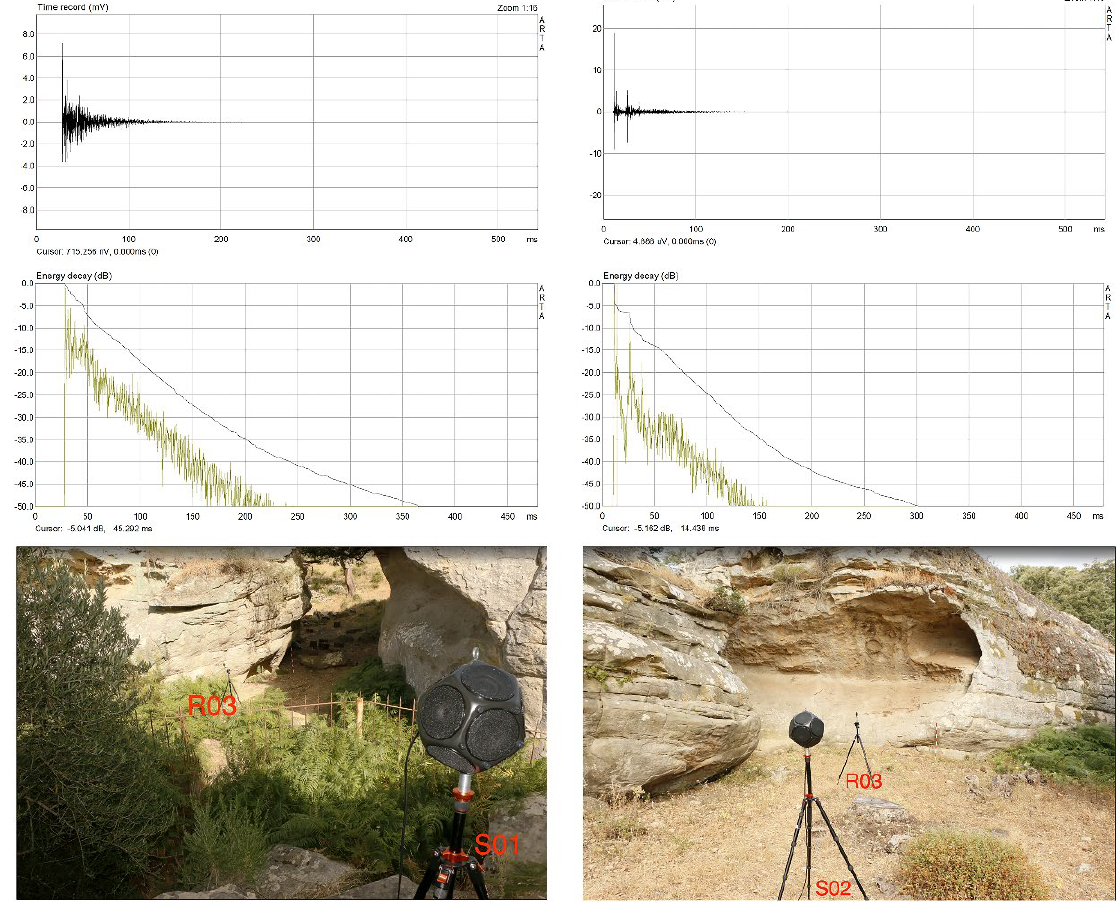
Figure 5. Impulse response (IR) and its early decay curve (EDC) captured at Bacinete main shelter with the source placed in front of the paintings (S1) and the receiver in the “audience” area (R3) (left column); and at Bacinete III, with the source in the middle of the audience area (S2) and the receiver next to the paintings (R3) (right column).